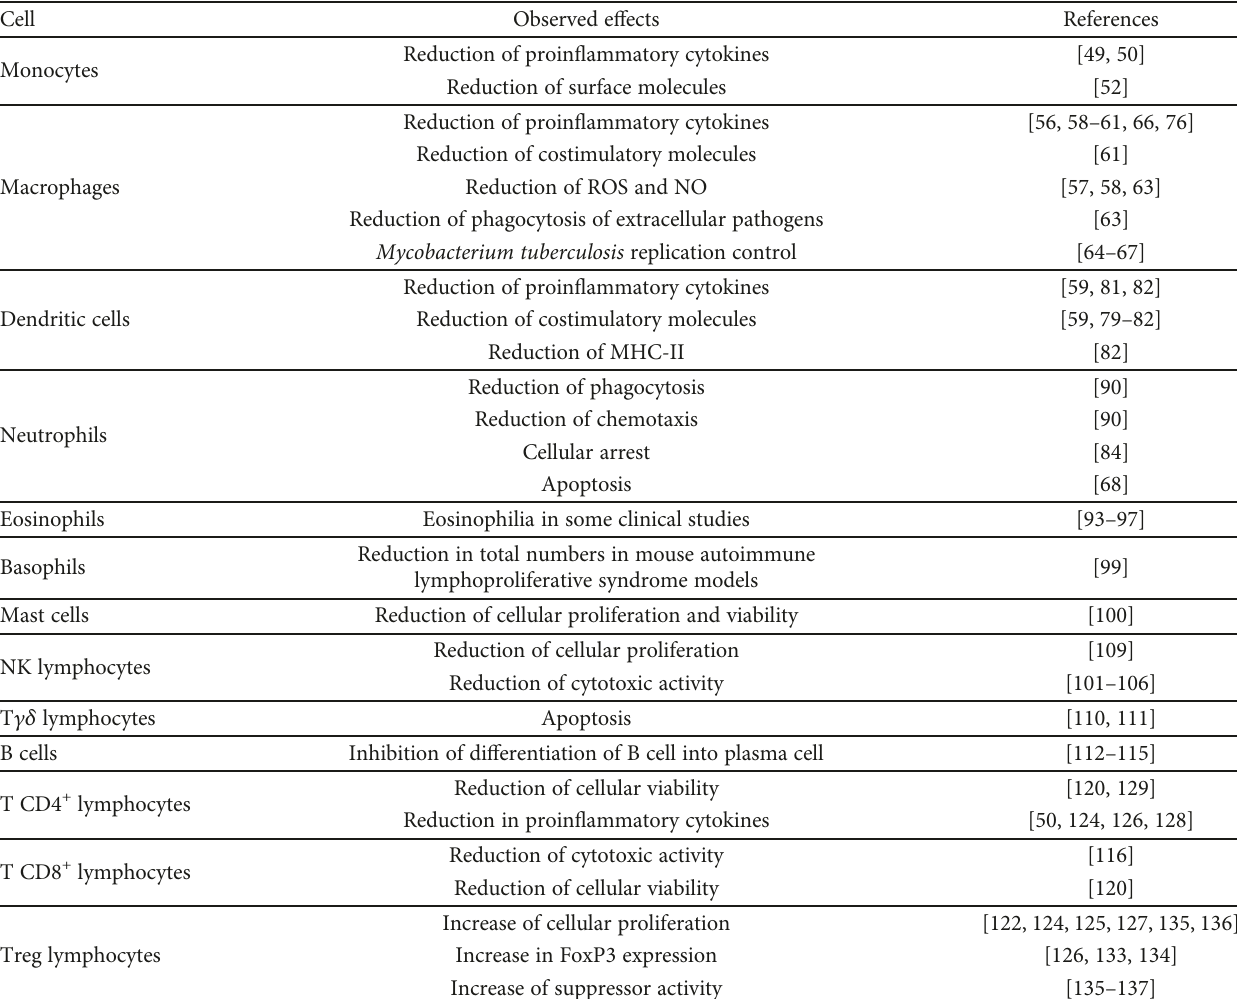
Table 2: E ff ects of valproic acid on some cellular elements of the immune